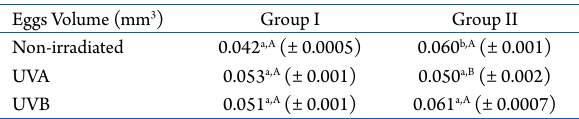
Table 1. Egg volume of Macrobrachium olfersii from groups I and II in each UVA and UVB irradiation